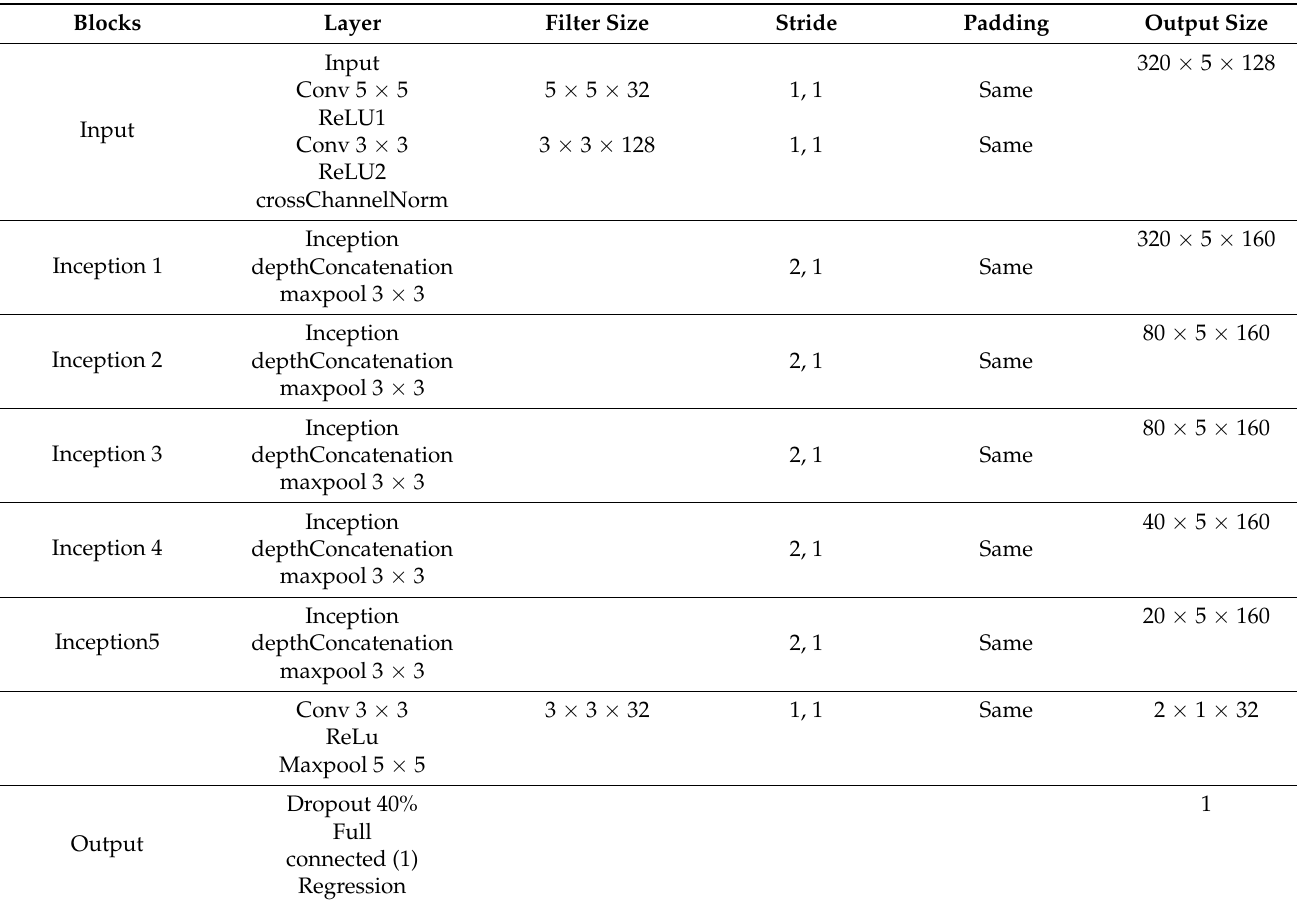
Table 2. Network hierarchy and related parameters of the DL-TFF